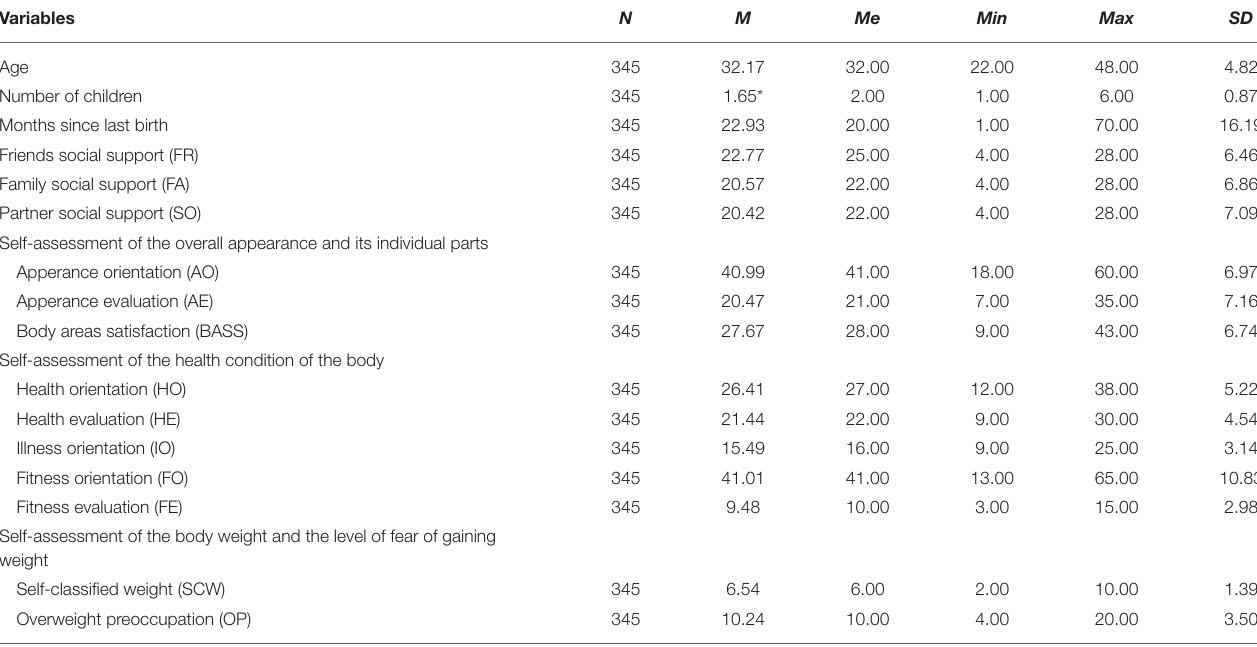
Self-classified weight (SCW) Overweight preoccupation (OP)